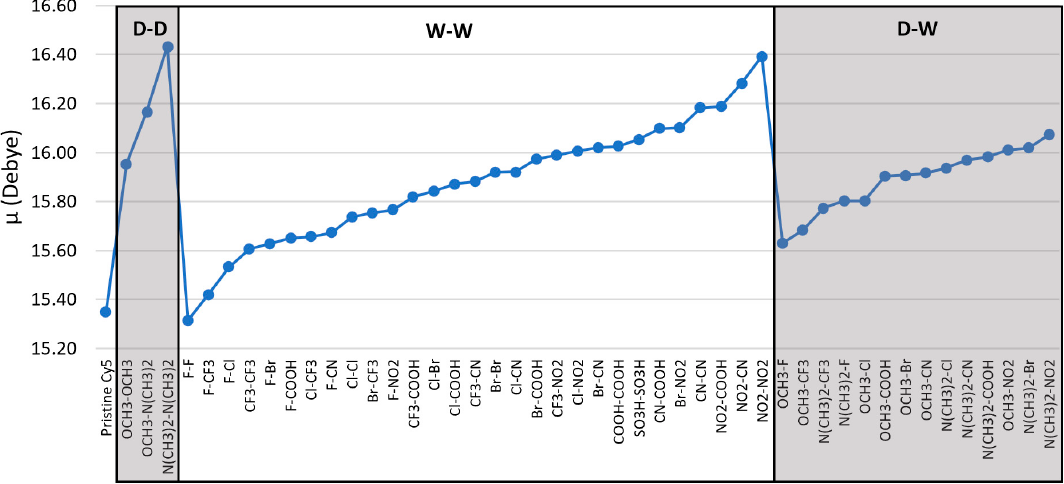
Figure 3. Transition dipole moment magnitudes ( µ ) of pristine and substituted Cy5 dyes. The given substituent groups are placed on R 1 and R 1 ’ sites in Figure 1. Geometry optimizations and excited state calculations were performed using the M06-2X functional. The dyes are grouped according to substituent classification and ordered by increasing µ . The lines added to the data are to highlight the trends of the data and are not meant to infer a quantitative behavior.